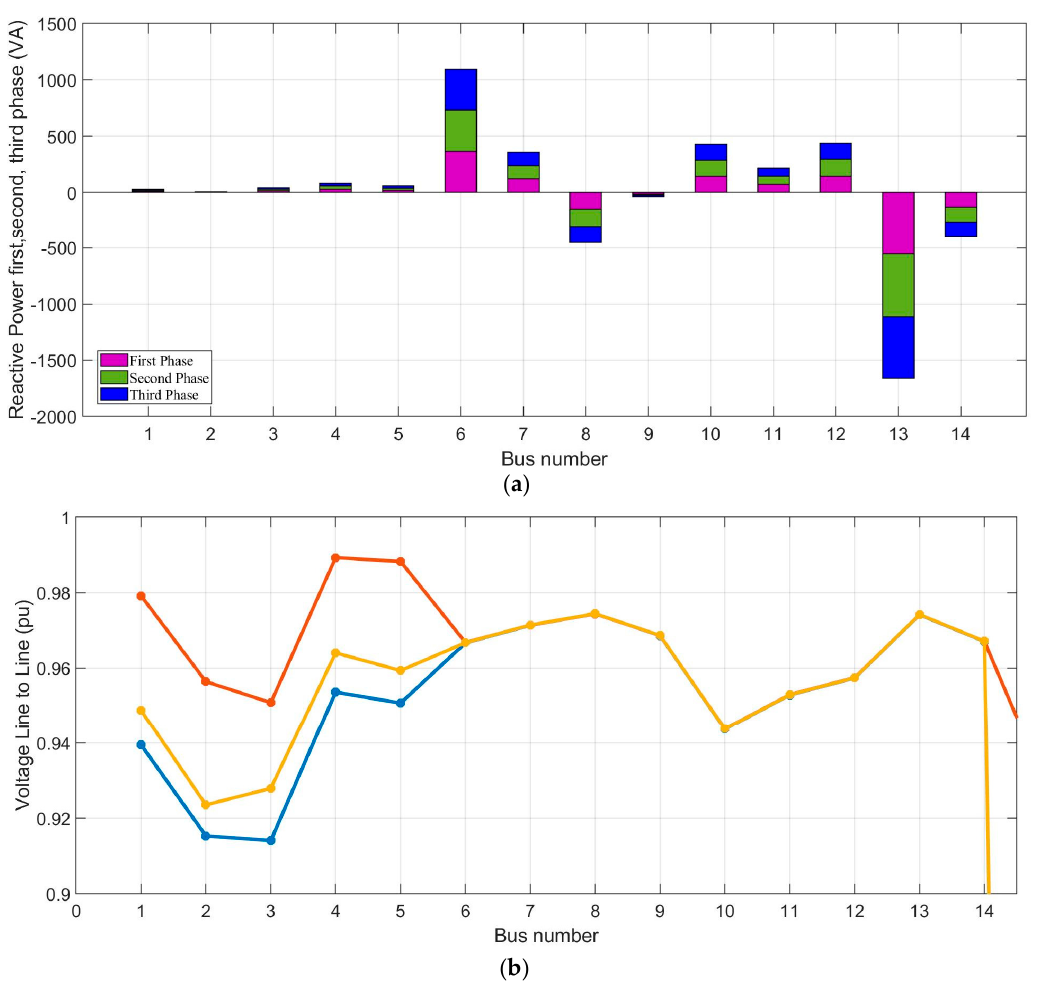
Figure 16. ( a ) The reactive power balance at maximum demand and7 ( b ) the voltage at maximum demand.